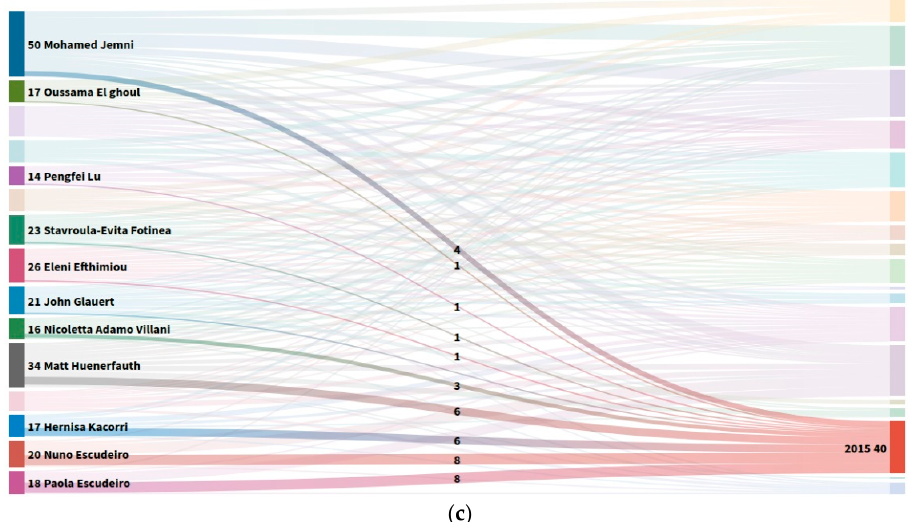
Figure 4. ( a ) Sankey diagram among top 10 authors and publication years [78–122]. ( b ) Sankey